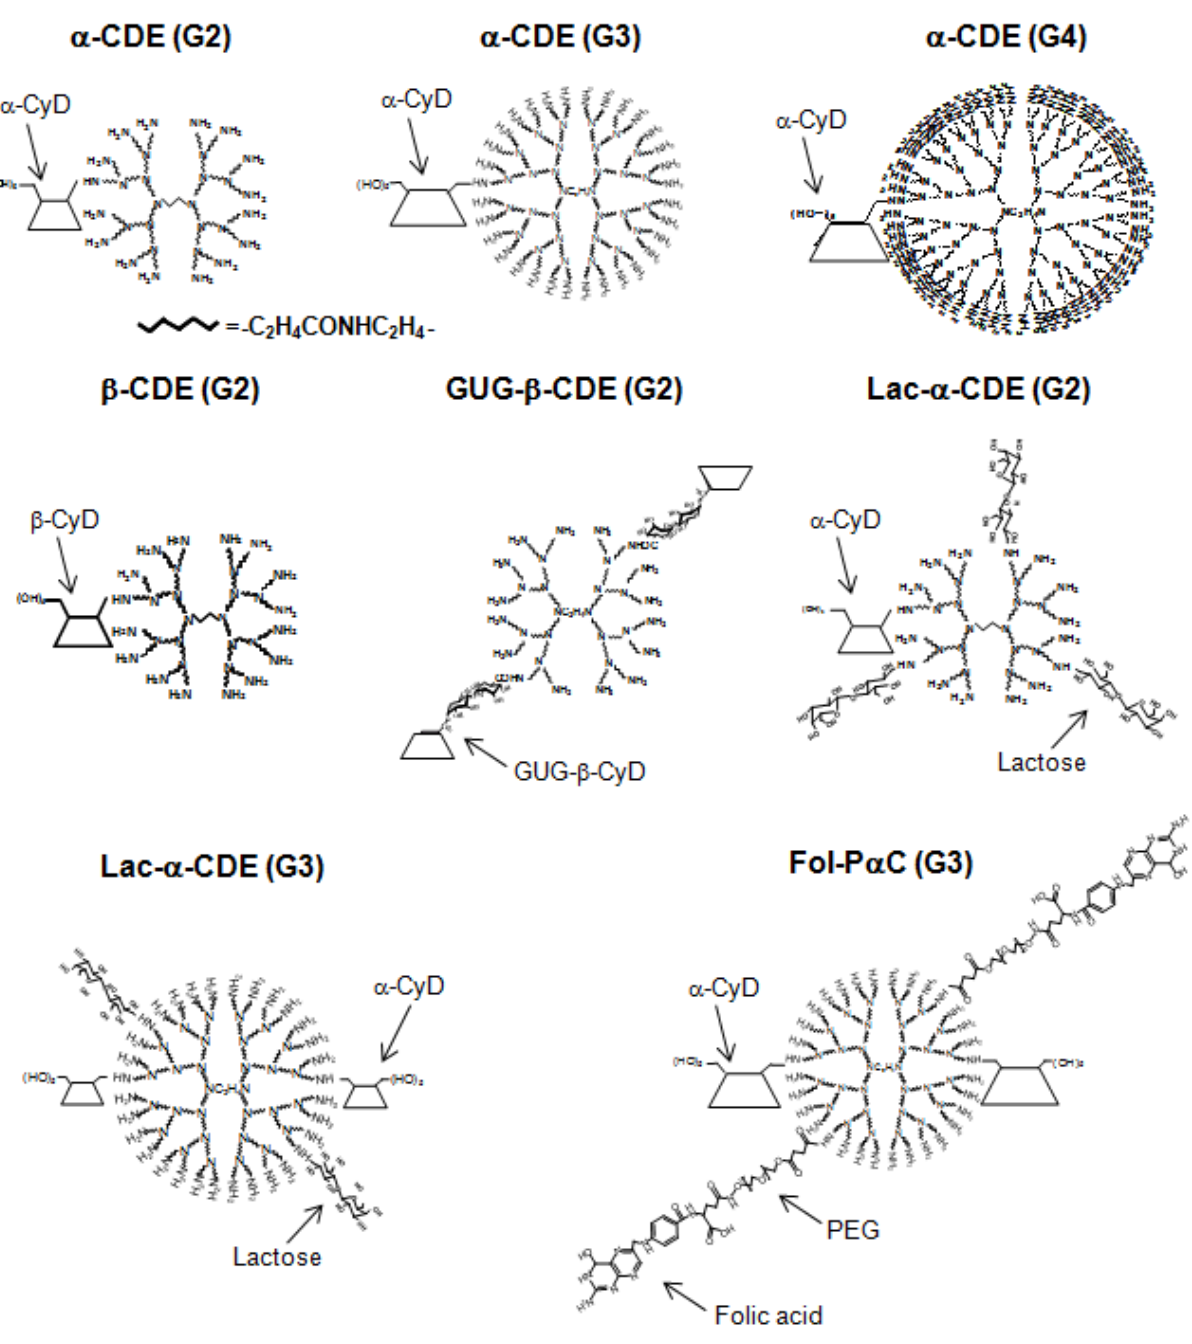
Figure 1. Chemical structures of representative CDEs described in this